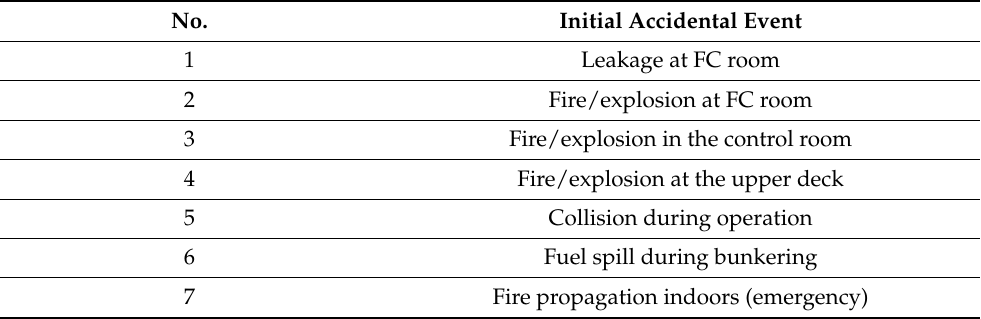
Table 4. The most severe hazards of the hydrogen-fuelled version from HAZID.